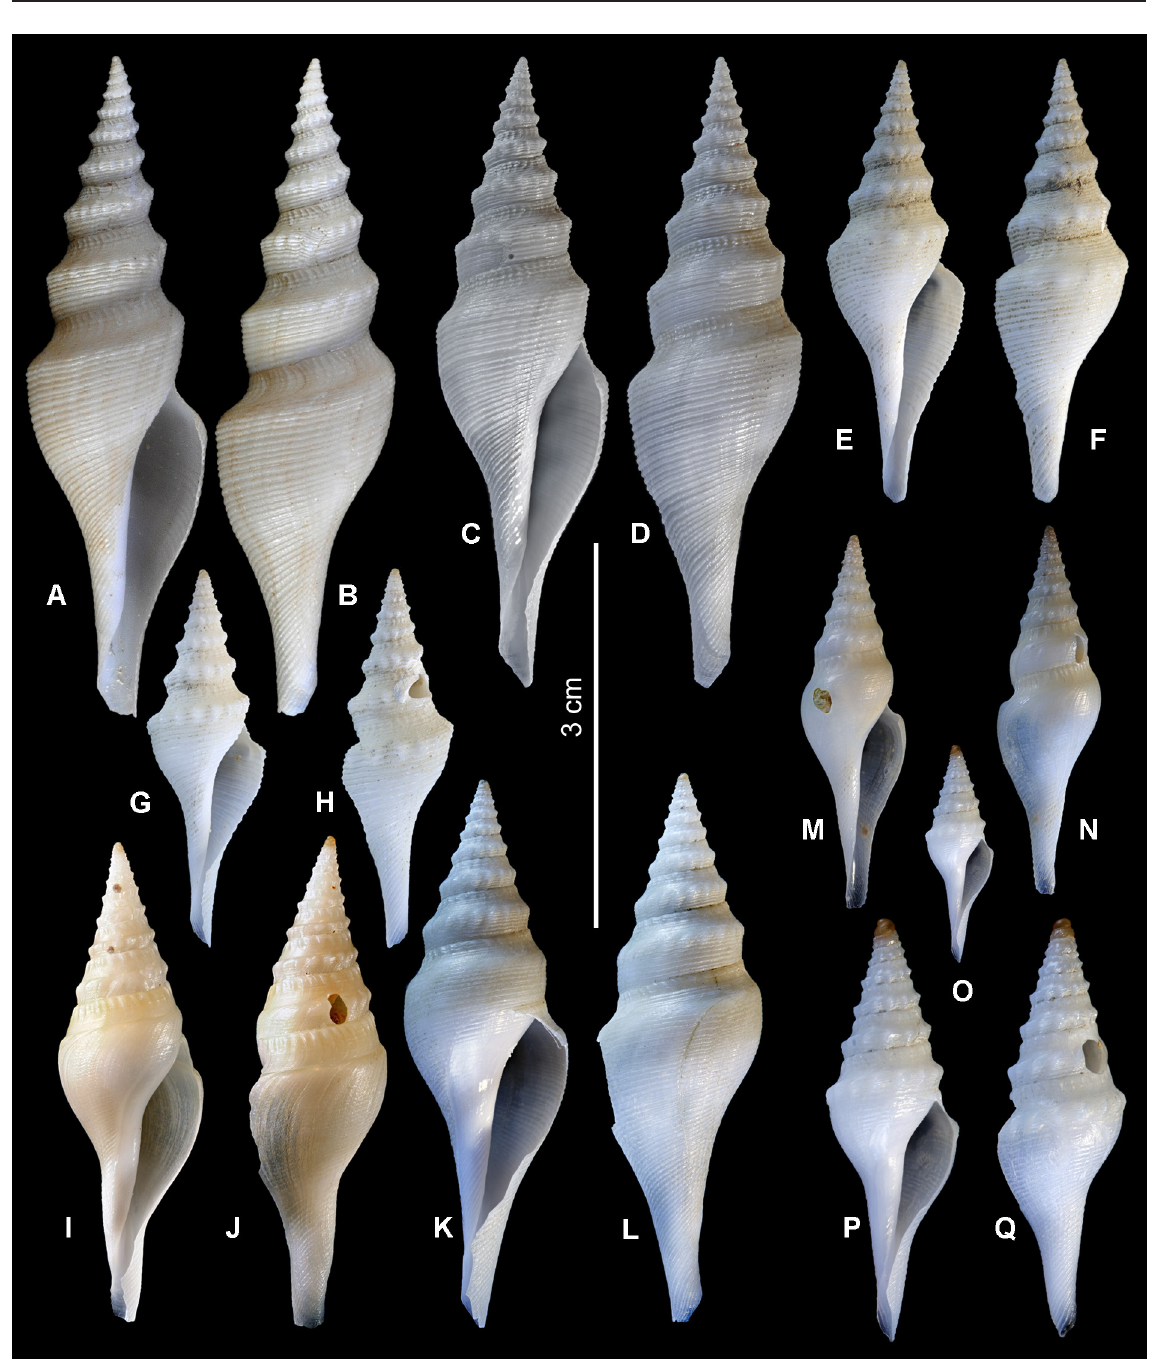
Fig. 9. A–H . Sibogasyrinx filosa Ardovini, 2021. A–B . Holotype, Solomon Islands (MNHN- IM-2000-37629), SL 52 mm. C–D . Solomon Islands, MNHN-IM-2007-42498, SL 49.9 mm. E–F . Solomon Islands, MNHN-IM-2009-16831, SL 34.4 mm (radula seen on Fig. 8C). G–H . Papua New Guinea, MNHN-IM-2013-59044, SL 29.9 mm. I–Q . Sibogasyrinx lolae sp. nov. I–J . Solomon Islands, holotype, MNHN-IM-42537, SL 37.3 mm. K–L . New Caledonia, MNHN-IM-2009-29230, SL 43.1 mm. M–N . New Caledonia, MNHN-IM-2009-29311, SL 29.1 mm. O–Q . New Caledonia, MNHN-IM-2013-48156, SL 17.1 mm (O at the same scale as the other specimens, P–Q enlarged). All shells (except P–Q) to same